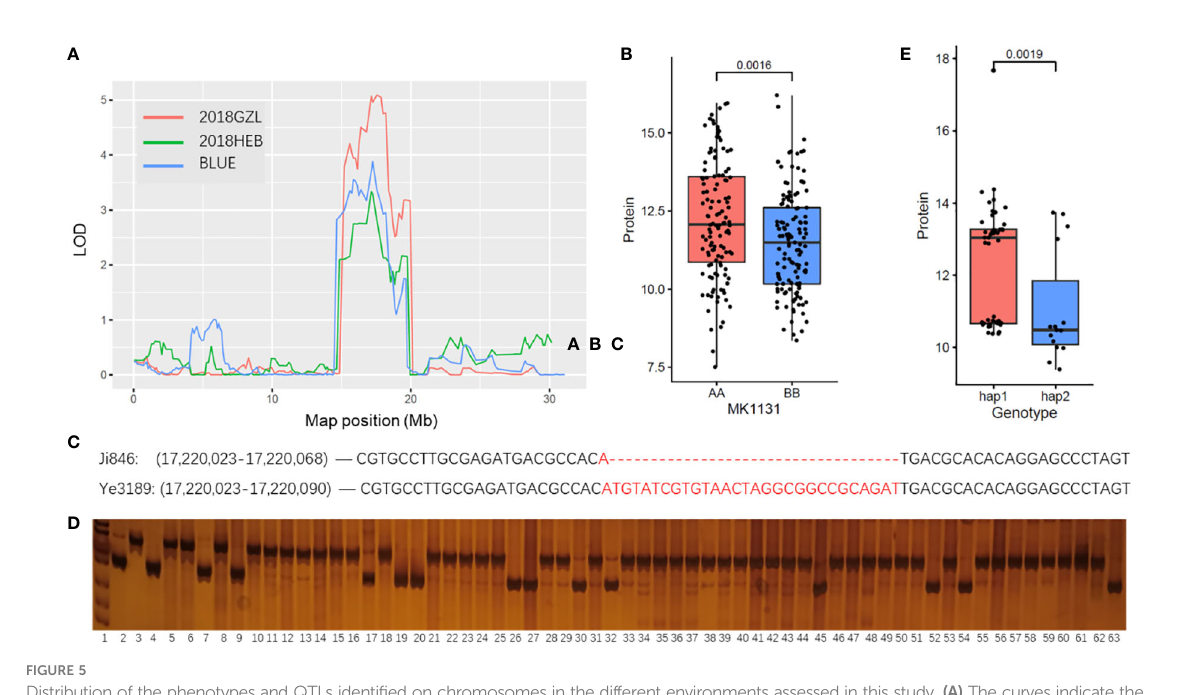
FIGURE 5 Distribution of the phenotypes and QTLs identi fi ed on chromosomes in the different environments assessed in this study. (A) The curves indicate the physical positions (x-axis) of bin markers against the LOD scores (y-axis) for QTLs detected on qPC2-2 . Different colors represent different environments. 2018GZL and 2018HEB represent Gongzhuling and Harbin in 2018, respectively; BLUE represents joint analyses. (B) Tests for differences among phenotypic values for the BLUE values of PCs associated with MK1131 in maize inbred lines. AA represents the Ji846 genotype; BB represents the Ye3189 genotype. The y-axis indicates the phenotypic values for the BLUE values of PC. (C) Indels between Ji846 and Ye3189 around the peak position (MK1131) in qPC2-2 . (D) Genotyping of maize inbred lines with 30 high and 30 low PCs using marker IndelPC2-2, lane 1: marker; lane 2: genotype of Ji846; lane 3: genotype of Ye3189; lane 4-63: genotypes of 60 inbred lines. (E) Tests for differences among phenotypic BLUE values of PCs associated with the IndelPC2-2 marker in maize inbred lines with 30 high and 30 low PCs. Hap1 represents Ye3189 genotype; hap2 represents Ji846 genotype. The y-axis indicates the phenotypic values for the BLUE values for